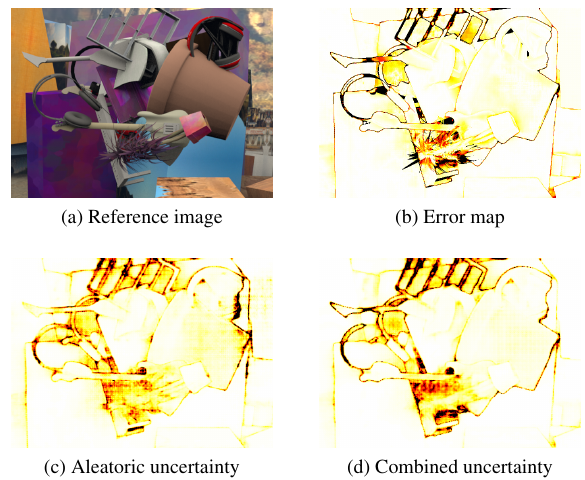
Figure 1: Advantages of modelling epistemic